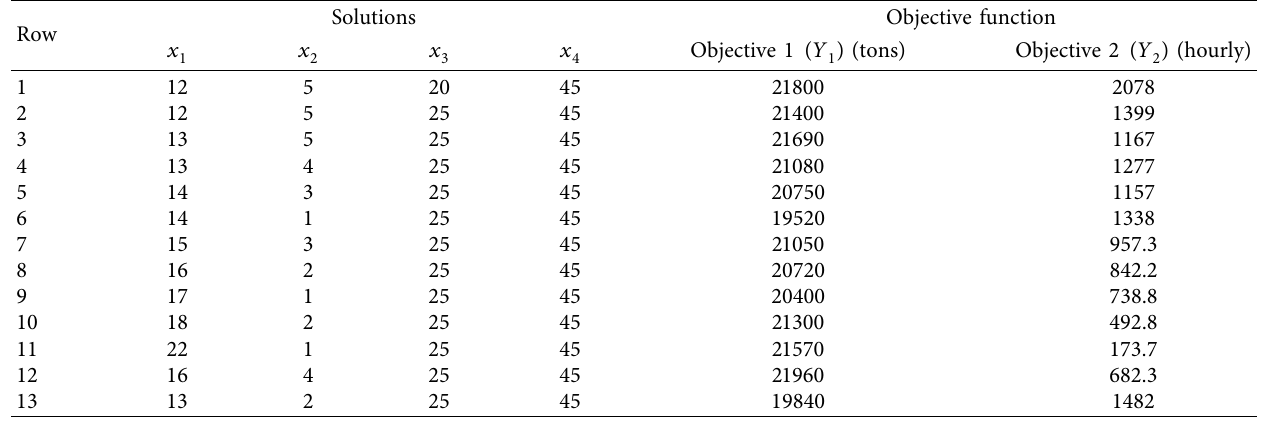
Table 10: Pareto points obtained.